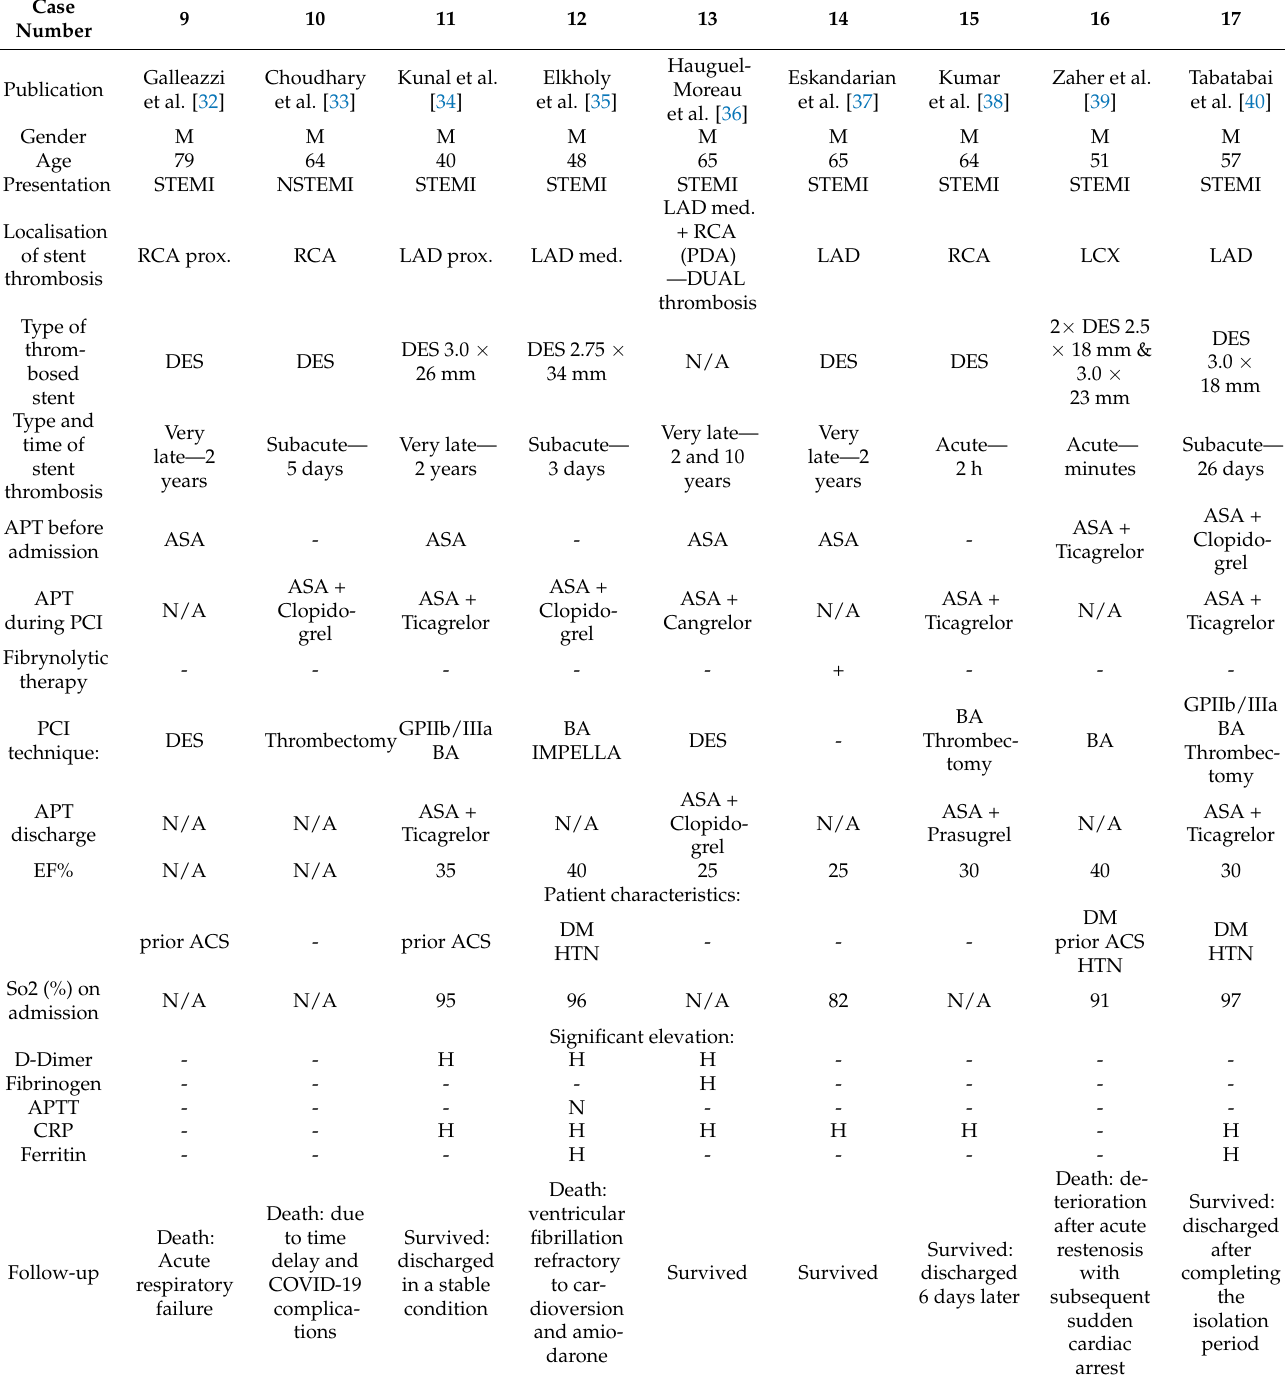
Table 3. Patients characteristics and procedure